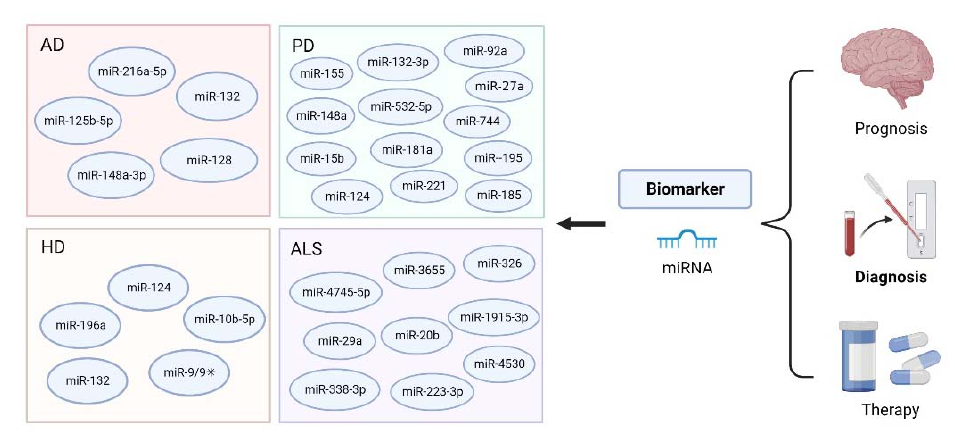
Figure 8. Potential miRNAs for the early diagnosis of neurodegenerative diseases.